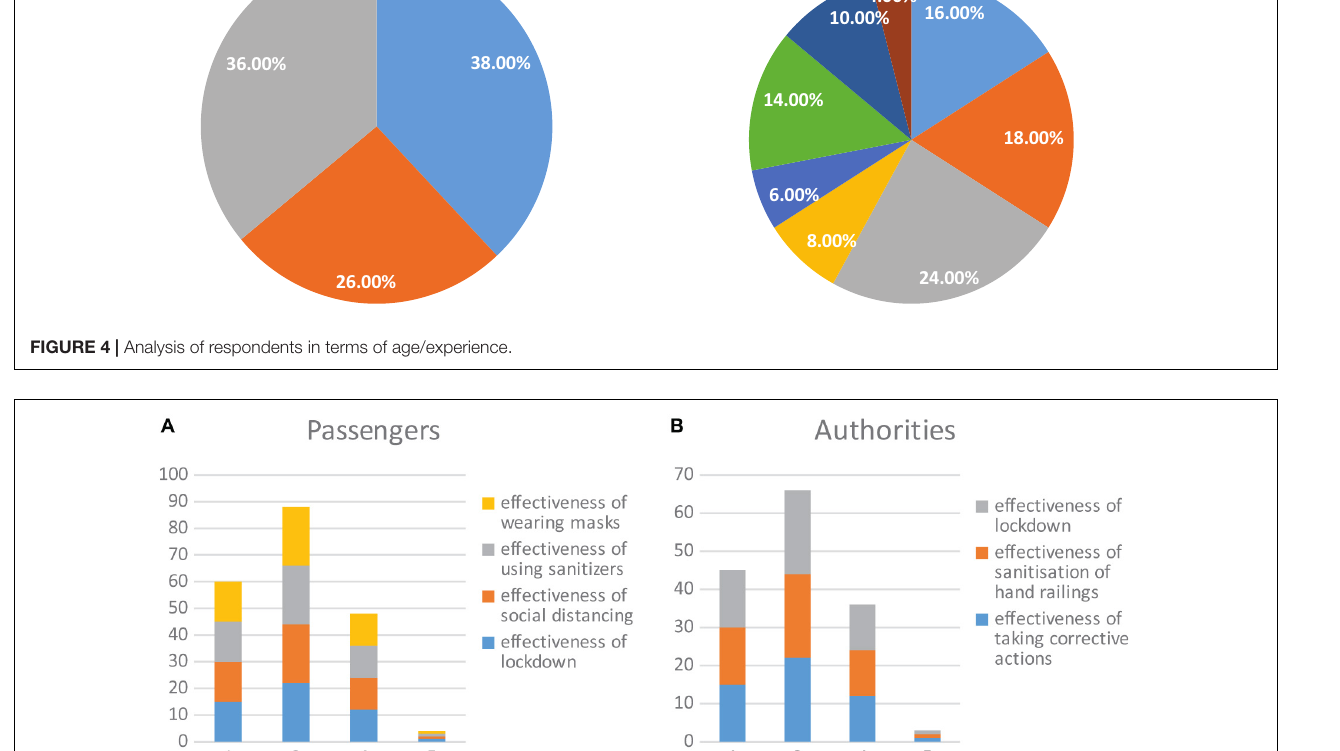
degree (see Figure 6B ). The lockdown and control measures imposed by the railway authorities have been effective. Further, people in Wuhan also realize the negative connotations of the disease and thus comply with the ban on transport. It is due to